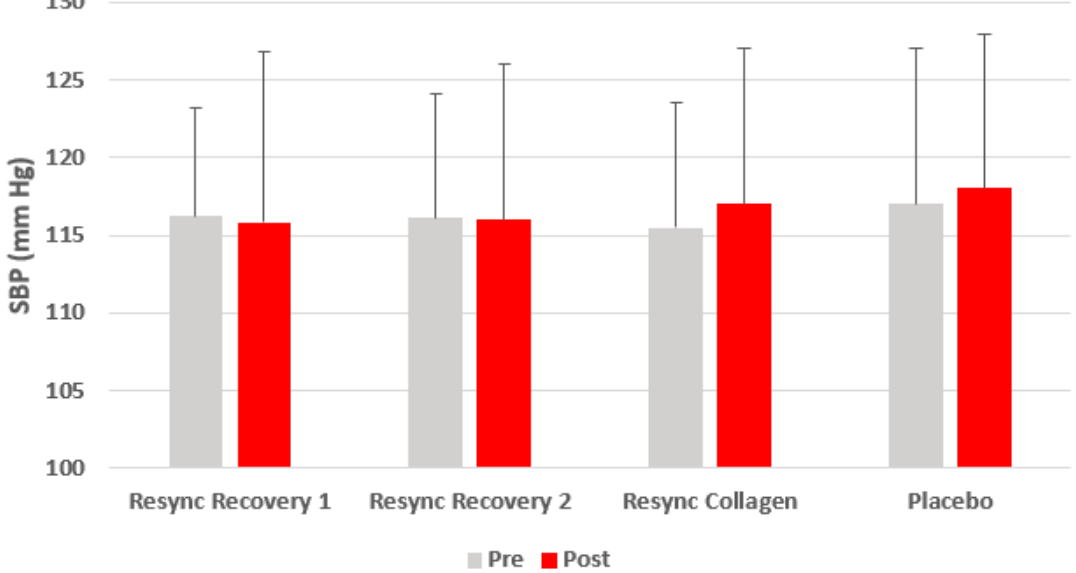
Figure 2. Systolic blood pressure before and 75 min after ingestion of Resync or placebo. Values are the mean ± SD. No differences of statistical significance were noted ( p > 0.05). Note: Resync Recovery 1 = 1 serving; Resync Recovery 2 = 2 servings.